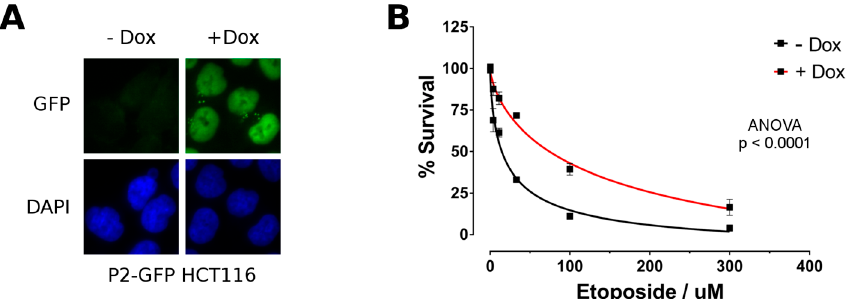
Figure 7. P2-GFP expression increases the resistance of HCT116 colorectal cancer cells to etoposide. The inducible HCT116 P2-GFP cell line was incubated 48 h with or without doxycycline to induce or not the expression of the P2-GFP construct. ( A ) Induction of P2-GFP expression was validated by monitoring GFP fluorescence by microscopy. Nuclei were counterstained using DAPI; ( B ) HCT116 P2-GFP cells induced ( + Dox) or not ( − Dox) with doxycycline were treated with increasing concentrations of etoposide for 72 h and cell viability was measured by alamarBlue. Etoposide sensitivity was determined by plotting the percentage of cell survival to etoposide concentration and fitting a four-parameter dose-response curve. n = 3; p -value calculated by the two-way ANOVA test.